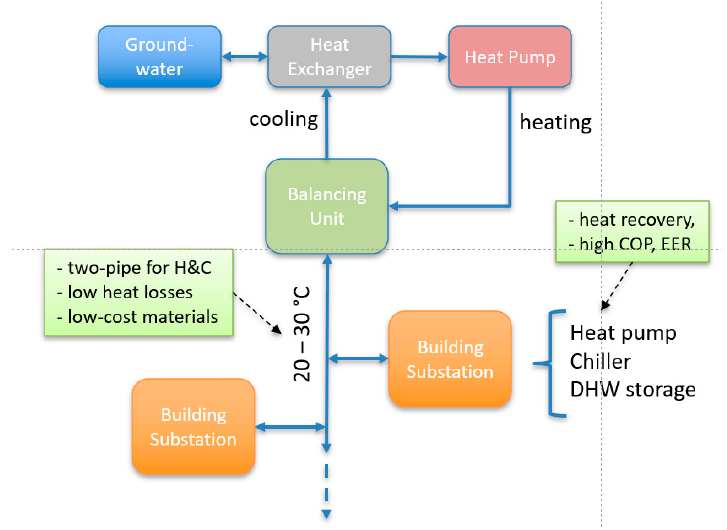
Figure 4. District heating and cooling based on fifth-generation thermal micro-grid.